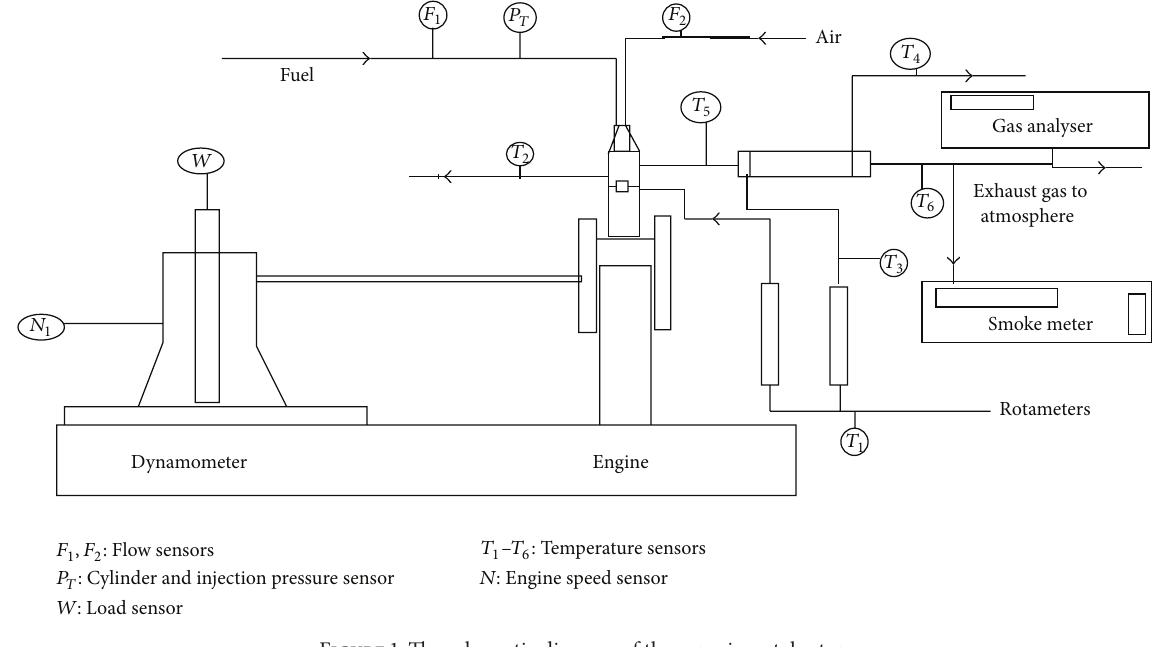
Figure 1: The schematic diagram of the experimental setup.